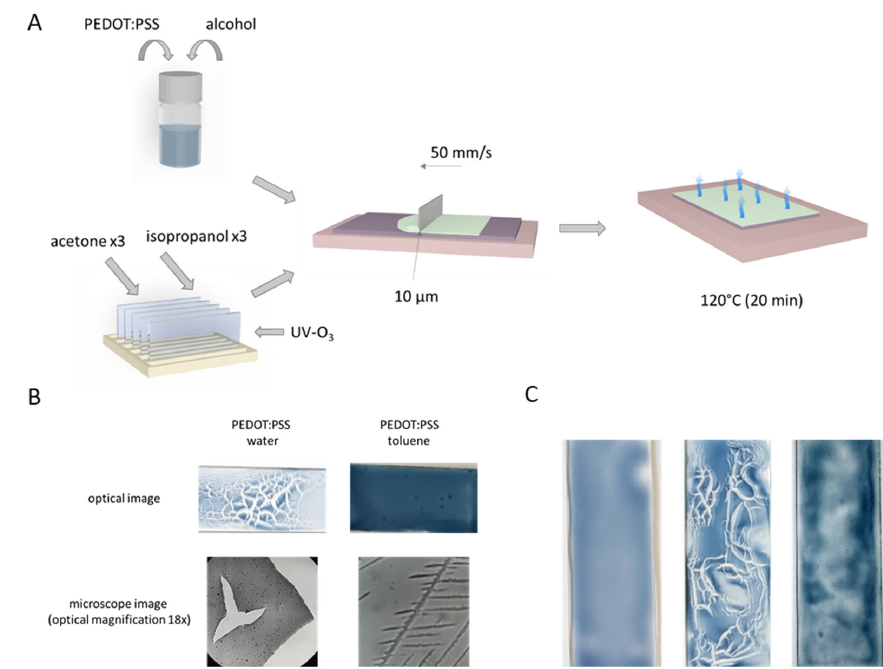
Figure 3. Scheme of layer preparation using doctor blade technique ( A ); images of PEDOT:PSS layers (10 µm gap, 50 mm/s) and microscopic images acquired at optical magnification of 18× ( B ); PEDOT:PSS (from water) layer (from left to right): directly after casting, after annealing, and layer made from PEDOT:PSS (from water:isopropanol) layer after annealing ( C ).